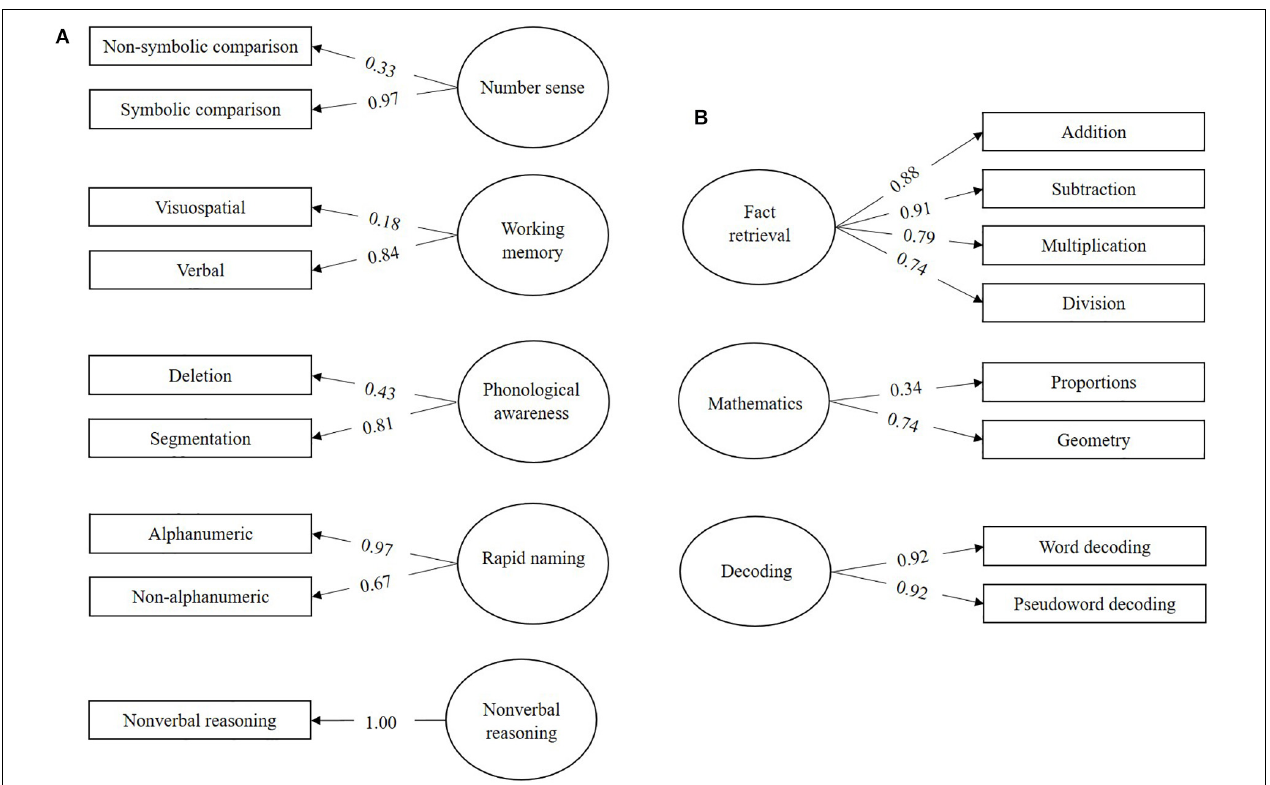
FIGURE 1 | Measurement model (CFA) for (A) the cognitive skills and (B) the behavioral outcomes in the combined sample of all children. Denoted values are beta weights.